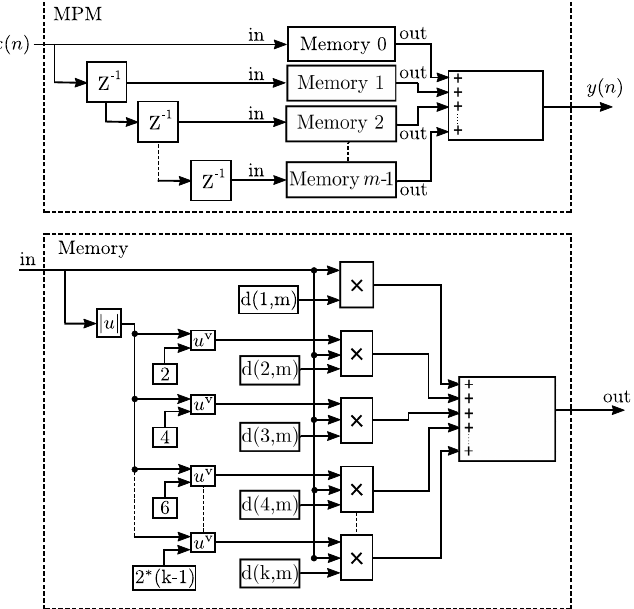
Figure 12. Block diagram for the polynomial model with